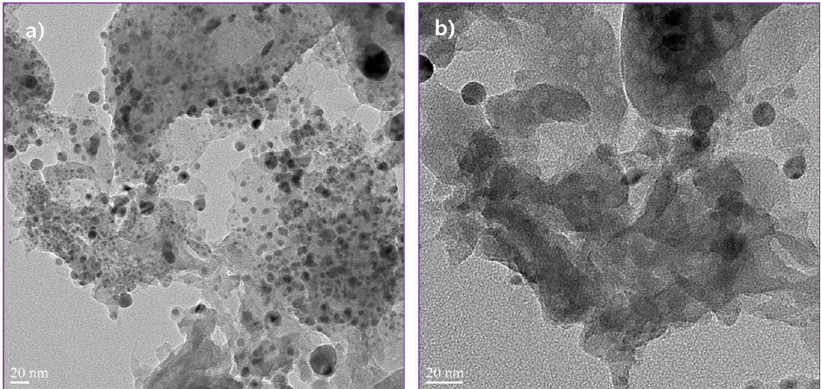
Figure 5. Transmission electron microscopy images of 0.02 Ag/g-C 3 N 4 structures, ( a ) low magnifi- cation and ( b ) high magnification.